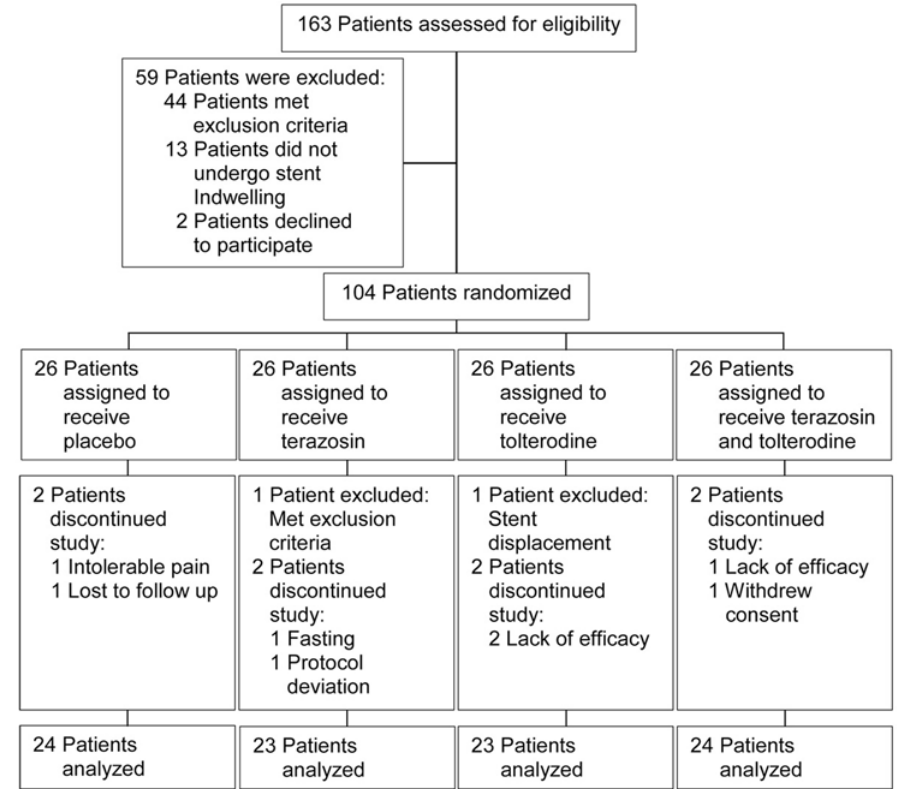
Figure 1 - Study flow